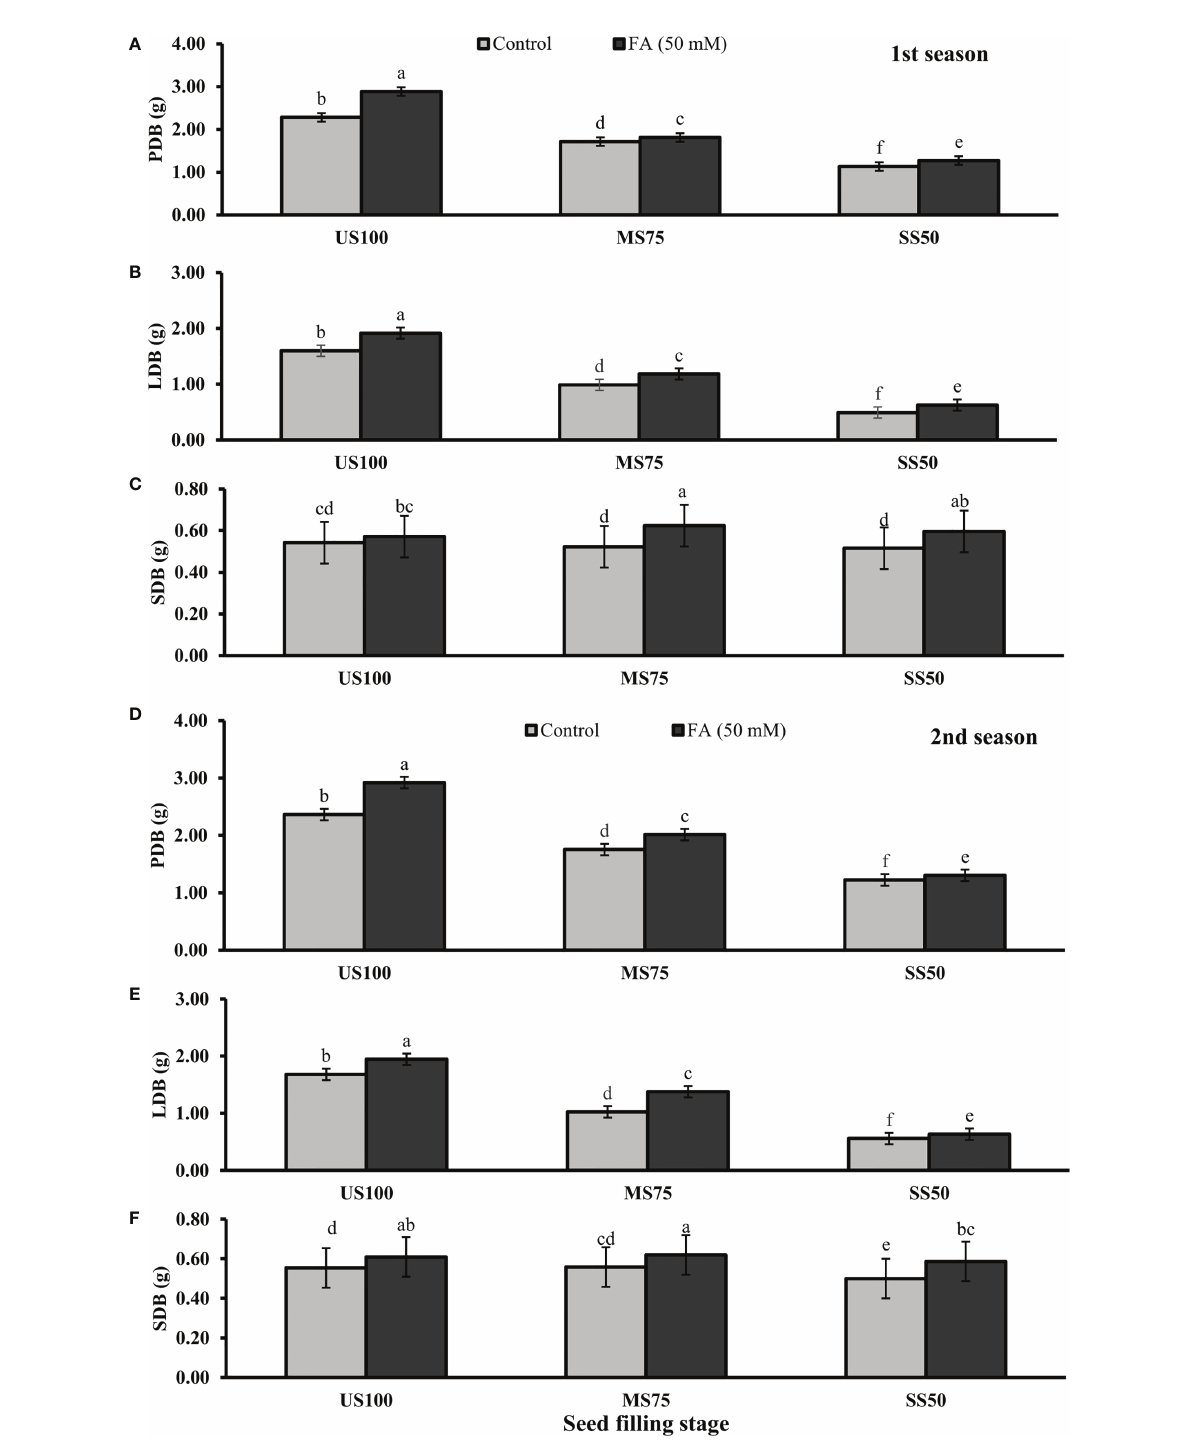
FIGURE 6 Effect of foliar application of folic acid (50 mM) at seed fi lling stage on (A, D) plant fresh biomass/plant, (B, E) leaf fresh biomass/plant, and (C, F) shoot fresh biomass in the fi rst and second seasons. The graph values are the mean ± SE of four replicates. The bars exhibited with different letters indicate a signi fi cant difference between samples by least signi fi cant difference ( p ≤